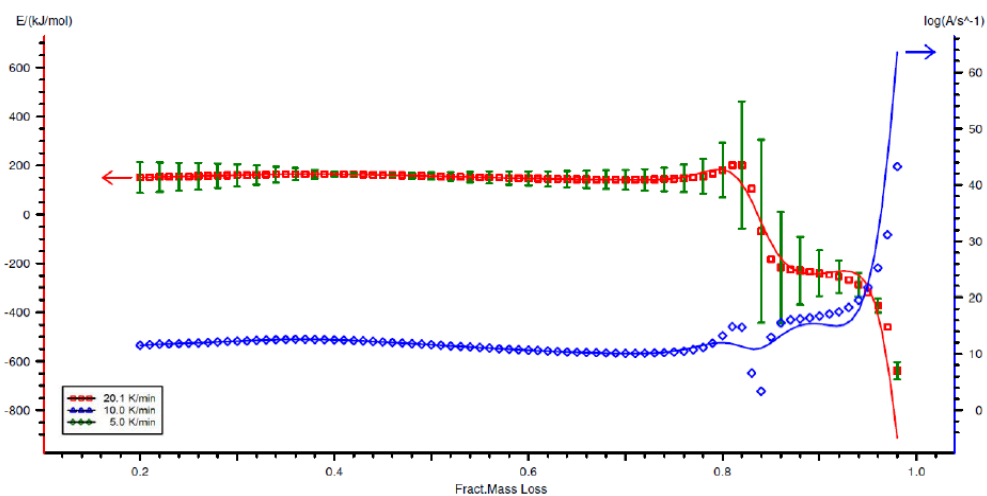
Figure 7. Activation energy and pre-exponential coefficient as a function of Ozawa–Flynn–Walla conversion for an oat straw sample.